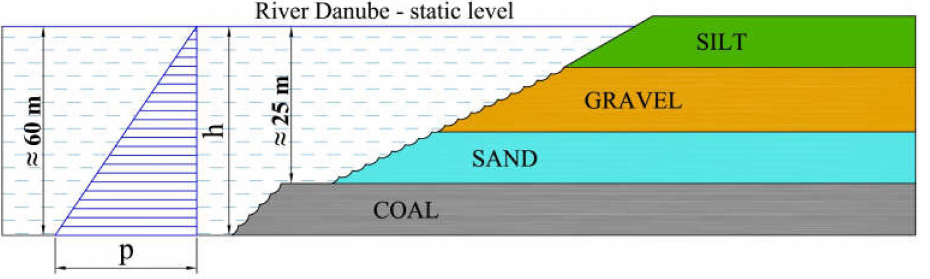
Figure 5. Schematic representation of the geological coal and gravel deposit, “Kovin”, with pres- sure changes with increasing depth.